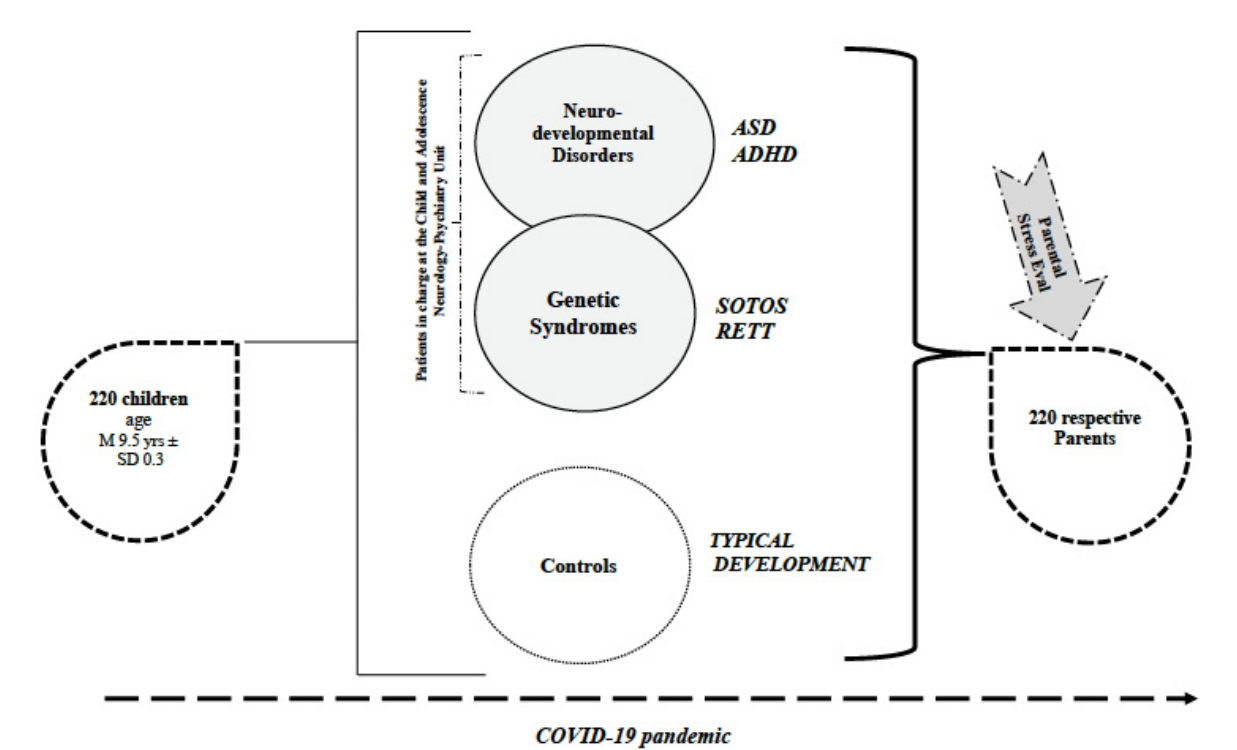
Figure 1. Overview of the Sample. Represented in the figure is the entire sample of the study as comprised of the study groups—individuals with neurodevelopmental disorders and genetic syndromes in charge at the Child and Adolescence Neurology Psychiatric Unit—and the typical development group. Parents of children belonging to each group underwent a Parental Stress Evaluation during COVID-19 pandemic. Legend: ASD = Autism Spectrum Disorder; ADHD = Attention Deficit and Hyperactivity Disorder; RETT = Rett Syndrome; Parental Stress Eval = Parental Stress Evaluation through Parental Stress Index-Short Form (PSI-SF).